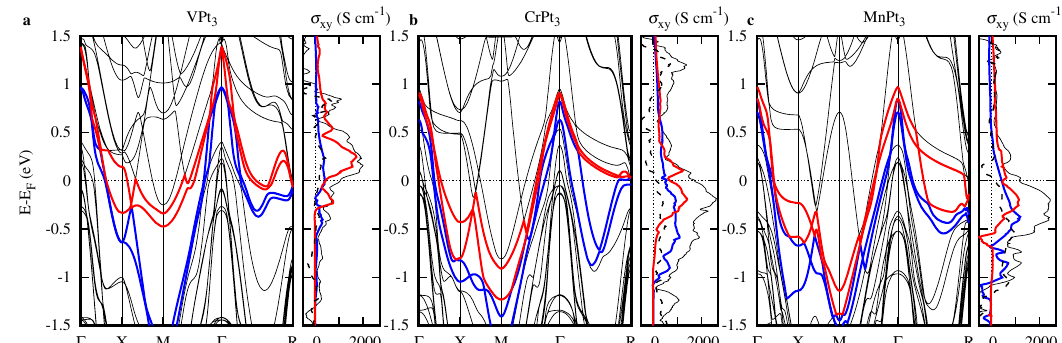
Fig. 2 Electronic structure and transport. Fermi energy dependence of band structure and of anomalous Hall conductivity in a VPt 3 , b CrPt 3 , and c MnPt 3 along with band projections, where E is the band energy and E F the Fermi energy for bands along the high symmetry directions of the cubic Brillouin zone and the anomalous Hall conductivity in S cm − 1 . The red and blue curves show the topological bands of interest and the corresponding projected anomalous Hall conductivity. The dashed curve in the anomalous Hall conductivity is for the projected bands below and above the red and blue bands. The solid black curve details the total anomalous Hall conductivity of